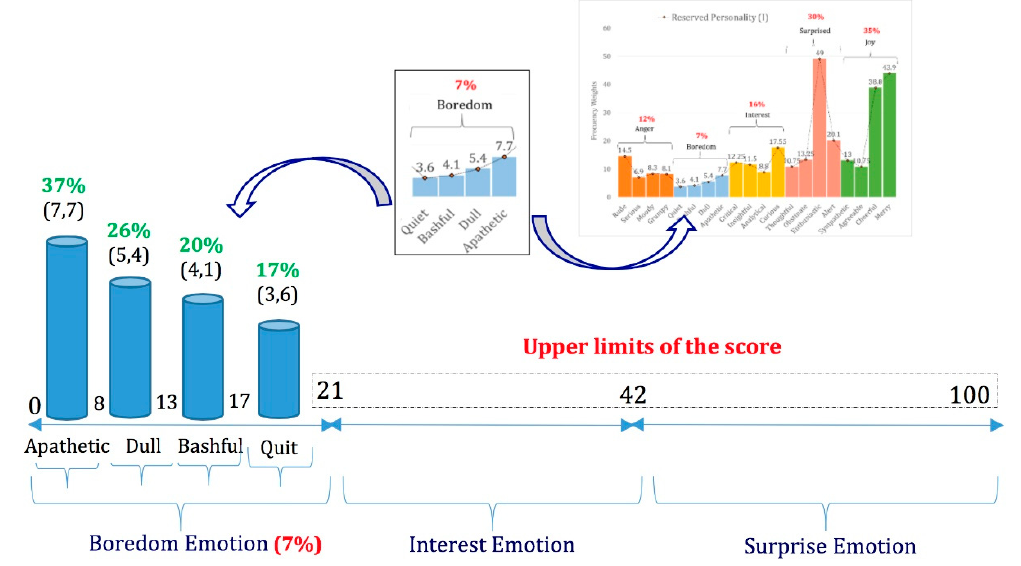
Figure 11. Example of the calculation of each behavior’s limits within an emotion.